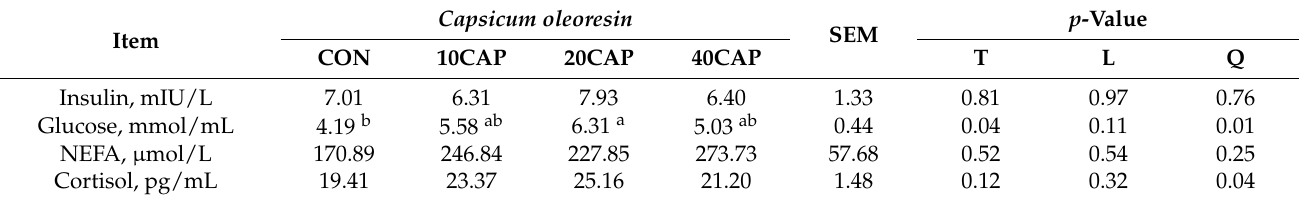
Table 5. Serum indicators as affected by Capsicum oleoresin (CAP)